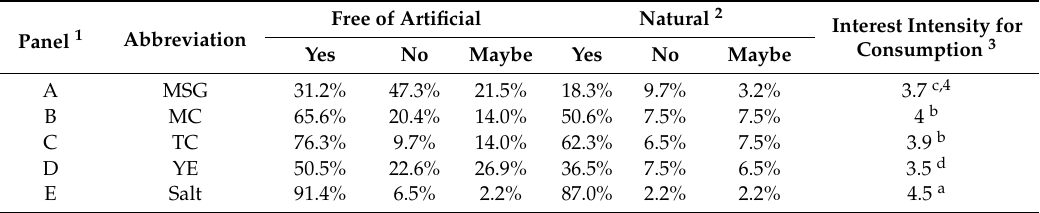
Table 4. Consumer perception about the five ingredient panels for chicken soup